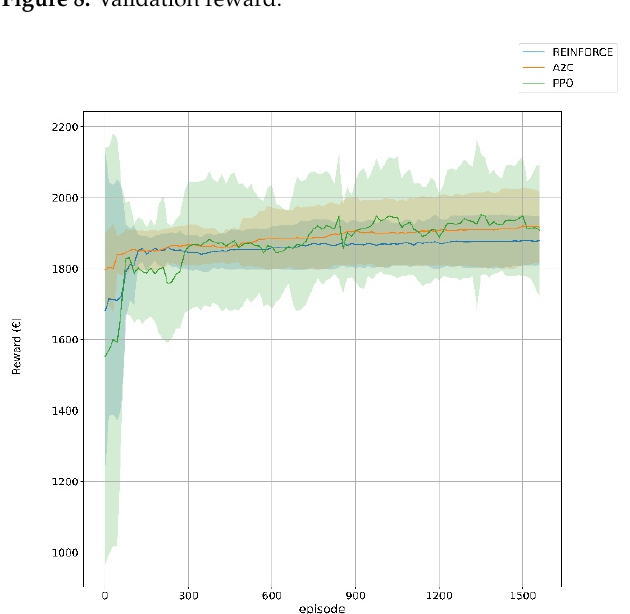
Figure 8. Validation reward.